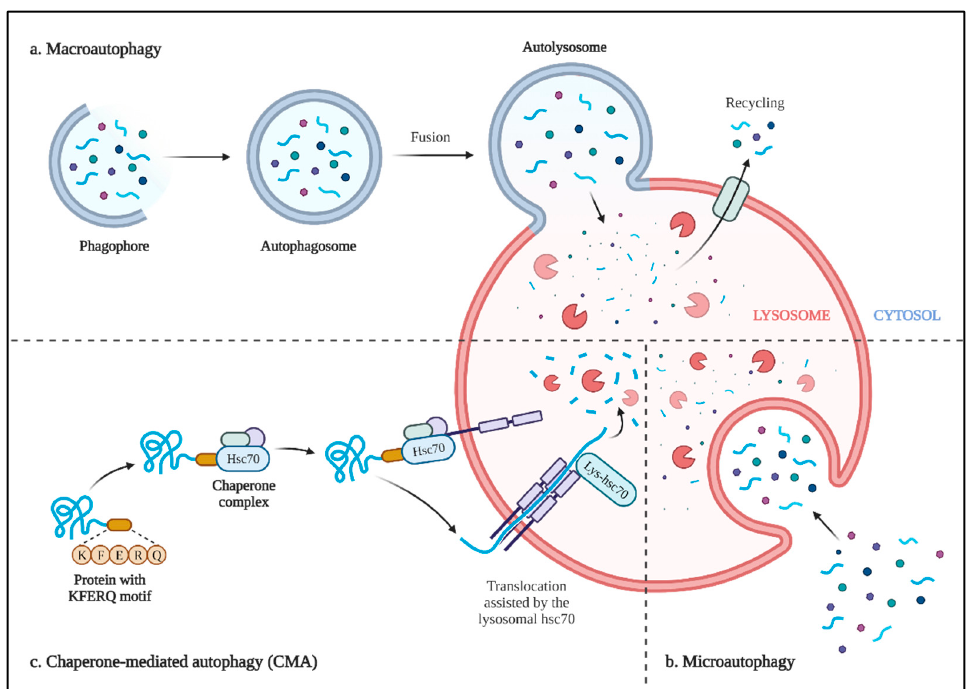
Figure 5. Three different types of autophagy. This schematic figure describes different types of autophagy. ( a ) Macroautophagy: a phagophore initiates by the assembly of several proteins, and the membrane sequesters the degradation target during autophagosome maturation. Following autophagosome and lysosome fusion, autolysosome forms and degradation starts with lysosomal proteases. ( b ) Microautophagy: some cytoplasmic materials are directly uptaken by lysosomes via the assistance of SNARE and ESCRT protein complexes. ( c ) Chaperone-mediated autophagy (CMA): this specific type of autophagy is specialized to degrade proteins with a KFERQ motif. This process is mediated by the chaperone complex and several proteins and is the only type of autophagy that is independent of vesicles. Targeted proteins are translocated to the lysosome via lysosomal membrane proteins. Regardless of the autophagy pathway, degraded materials are transferred to the cytosol by lysosomal membrane proteins, mainly permeases, to be recycled in other procedures. The illustration is created with BioRender.com. SNARE: soluble N-ethylmaleimide-sensitive factor attachment proteins receptor; ESCRT: endosomal sorting complex required for transport; Hsc70: heat shock cognate 71 kDa protein; K: lysine; F: phenylalanine; E: glutamic acid; R: arginine; Q: